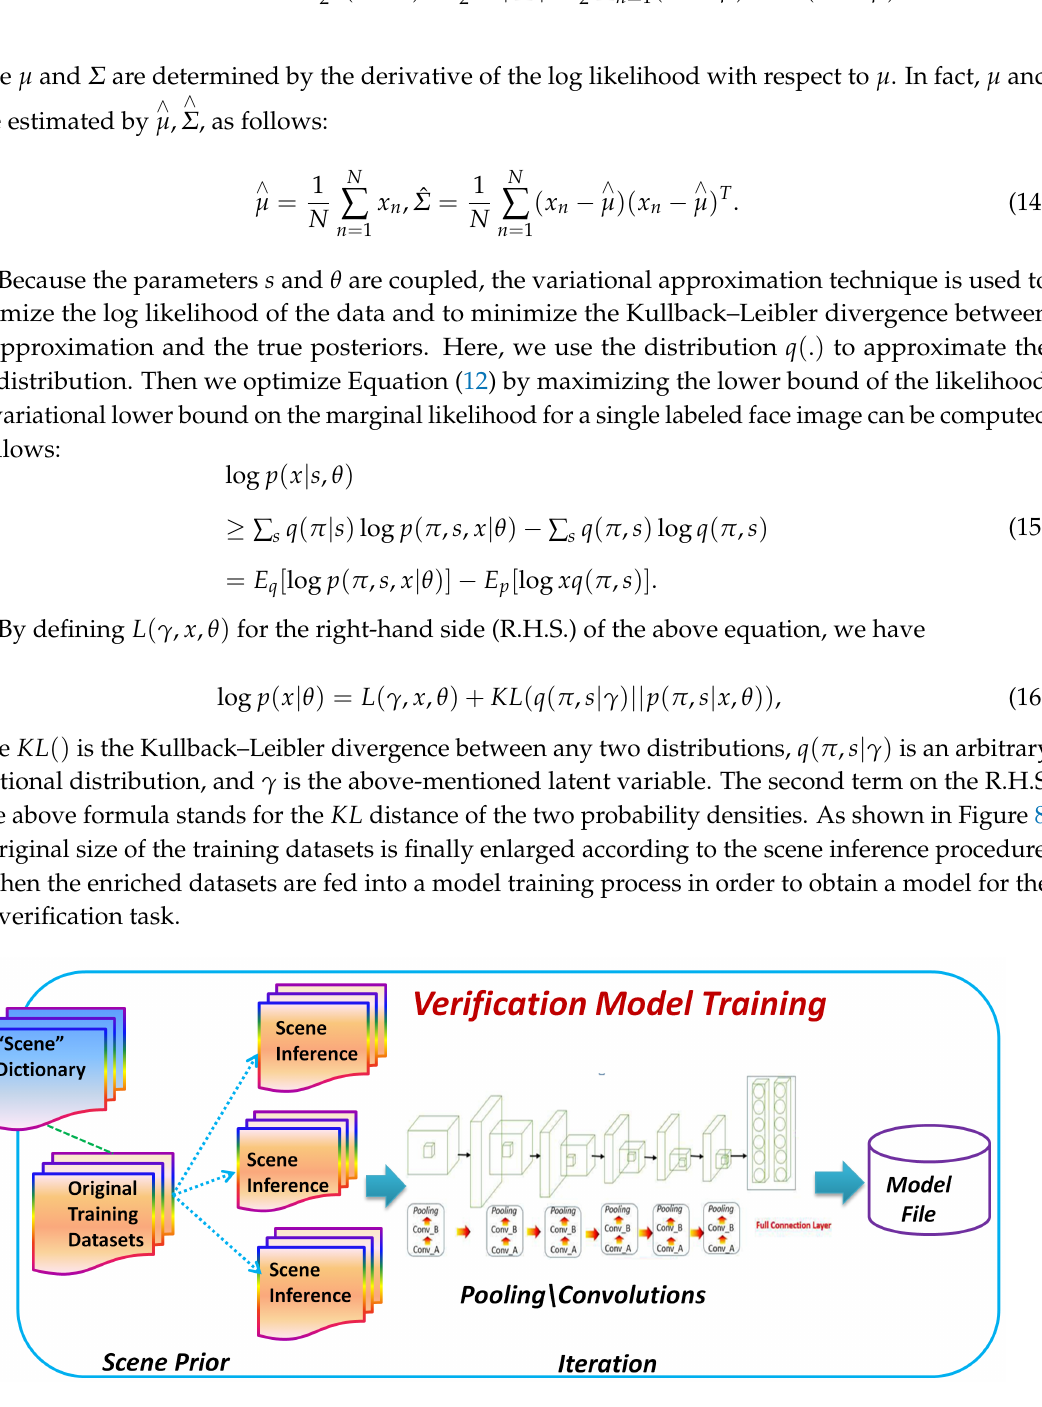
Figure 8. The illustration of the procedure for training a verification model on the basis of scene